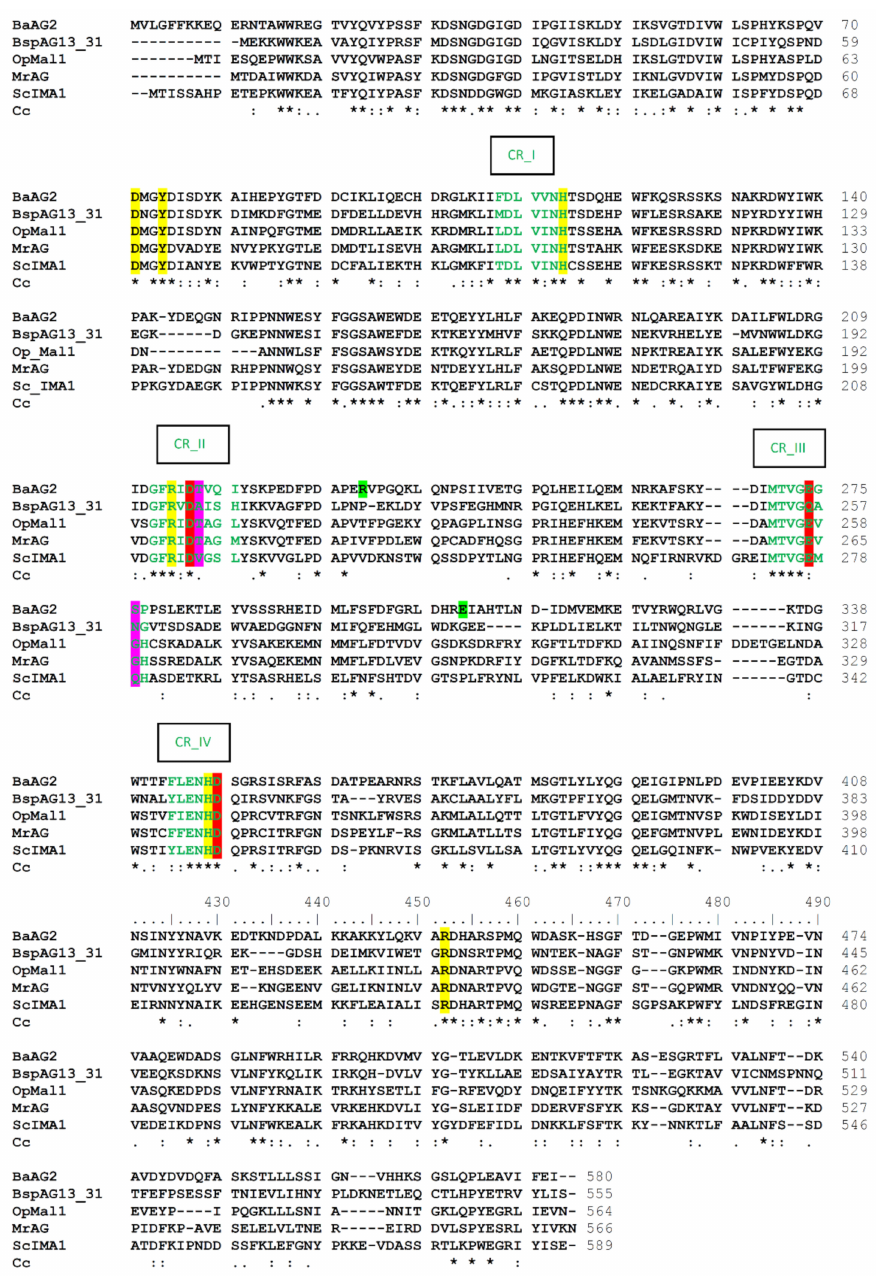
Figure 2. Clustal Omega alignment of amino acid sequences of Ba AG2 (GenBank: MZ467078, translation), BspAG13_31 ( α -glucosidase of Bacillus sp. AHU2216; PDB: 5ZCE), Op Mal1 (maltase- isomaltase Mal1 of O. polymorpha ; GenBank: XP_018213389.1, AWO14629.1), Mr AG ( α -glucosidase of M. reukaufii ; GenBank: QLP89119.1) and Sc IMA1 (isomaltase of S. cerevisiae ; GenBank: